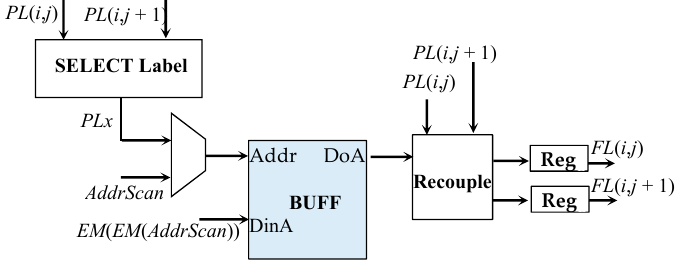
Figure 11. The FinLab module.